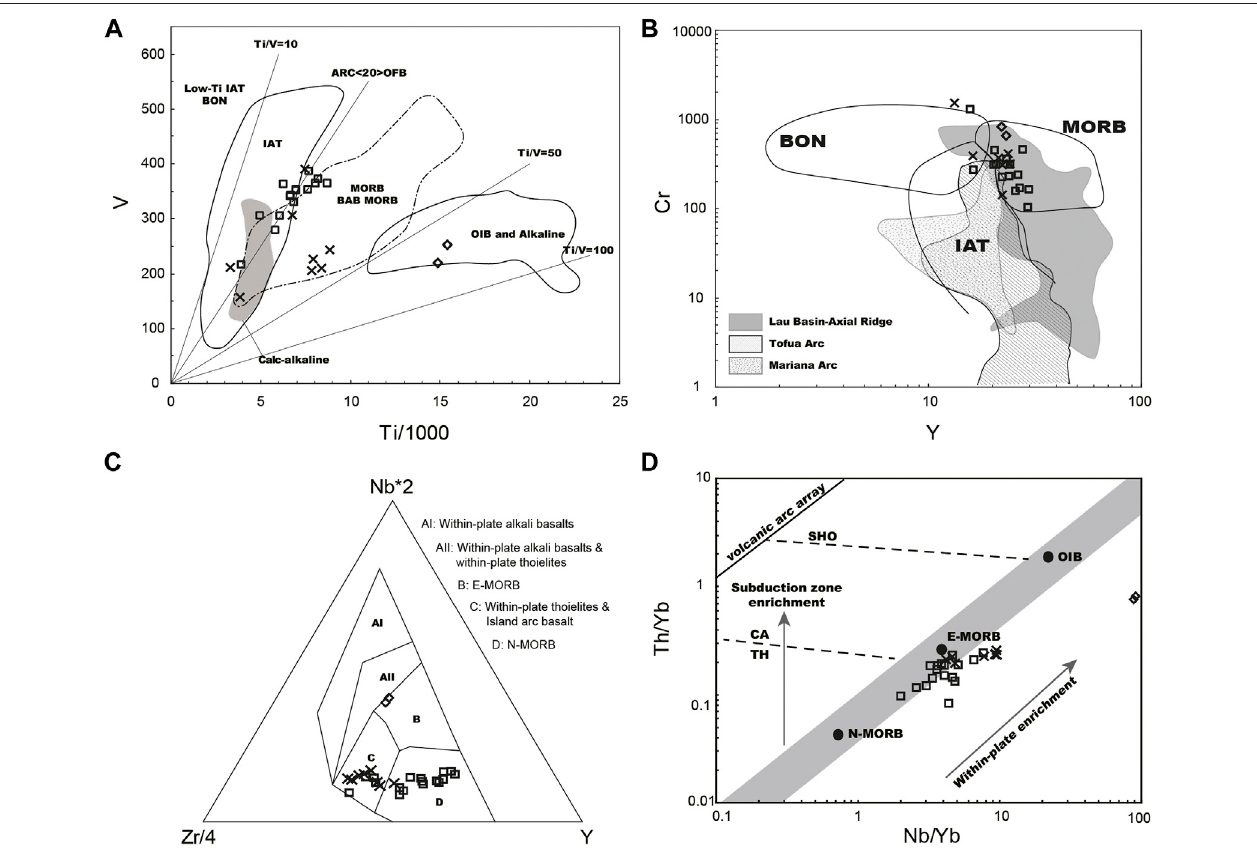
FIGURE11|(A) Tivs. Vdiscriminationdiagram fortherocks fromtheHuaniushancomplex(Shervais, 1982). (B) Crvs. Ydiscriminationdiagramfortherocksfrom the Huaniushan complex, after (Pearce et al., 1981), BON-boninite, IAT-island arc tholeiite, and MORB-mid-oceanic ridge. The fi elds of the Lau Basin-Axial Ridge, the Tofua Arc, Mariana Trough and Mariana Arc are after (Hawkins, 2003). (C) Nb-Zr-Y discriminant diagrams (Meschede, 1986) and (D) Th/Yb vs. Nb/Yb discriminant diagram [SHO: shoshonite, CA-Calc: alkaline, TH: tholeiite (Pearce, 2008)]. Symbols are the same as those in Figure 6